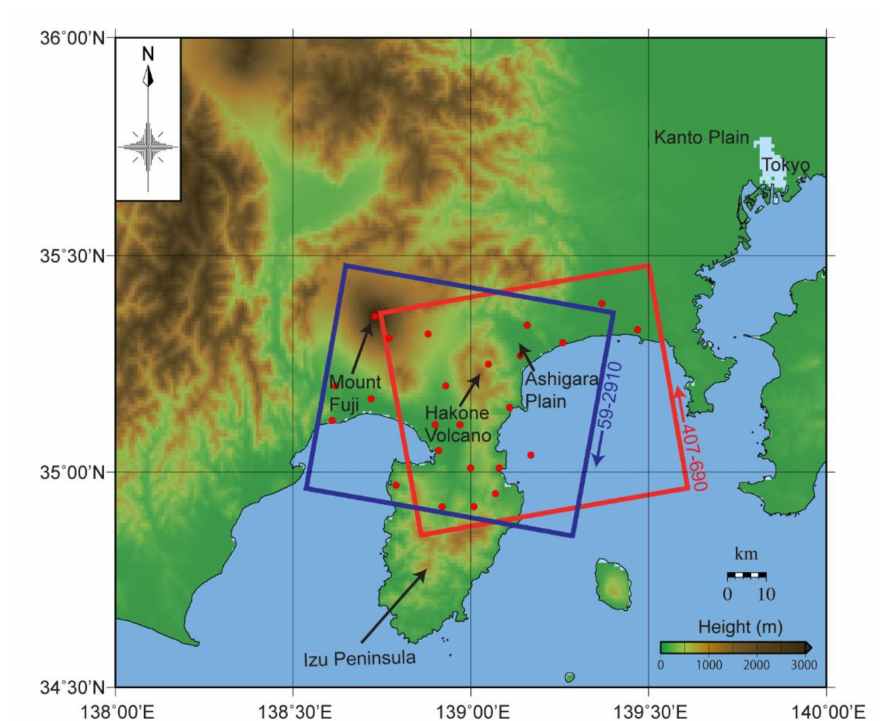
Figure 1. Map showing the area around Hakone Volcano. The topographical map is based on 50 m mesh height data released by the Geospatial Information Authority of Japan (GSI). The red and blue rectangles show the area included in the scenes of the ascending and descending orbits, respectively. Red points show the location of ground control points used for the analysis.